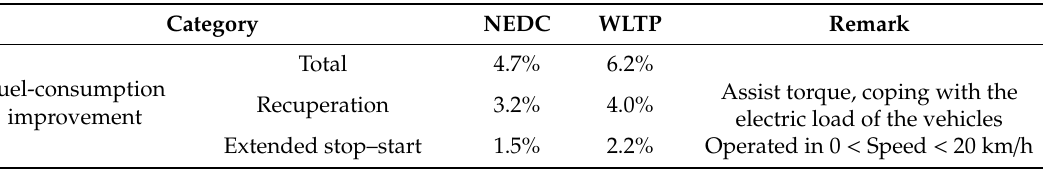
Table 9. Fuel-consumption improvement of the 48-V system according to drive cycle (1.6 L diesel engine).